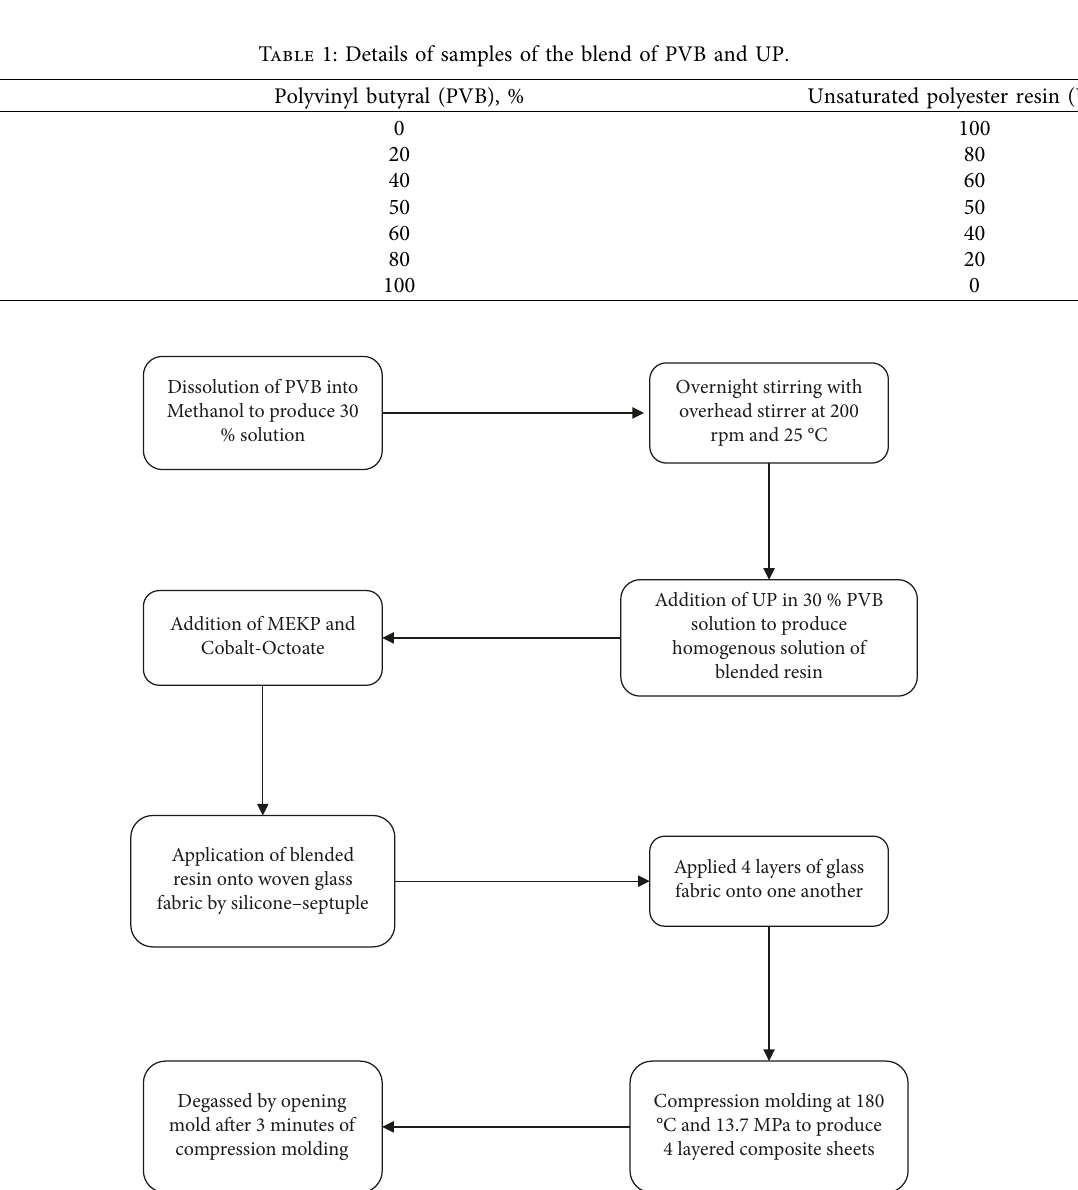
Figure 1: Process flow chart for blend and composite